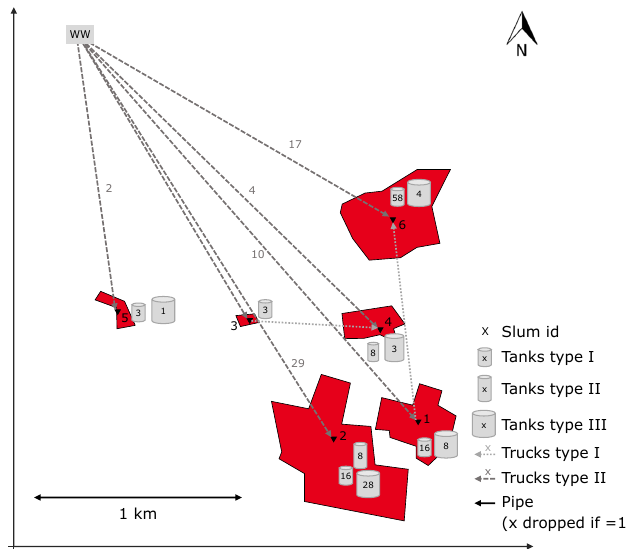
Figure 9. Optimization result for a slum cluster in Dar es Salam (2002),